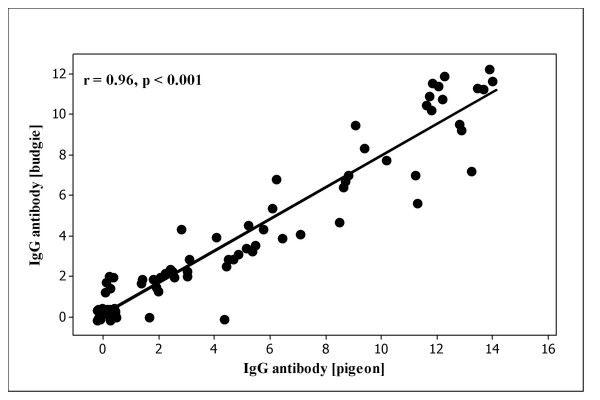
Comparison of the concentrations of serum IgG antibody [ug/ml] against pigeon serum antigens and budgerigar serum quantified by automated fluorimetry in 50 pigeon fanciers. A transformed (square root) scale has been used on both axes.